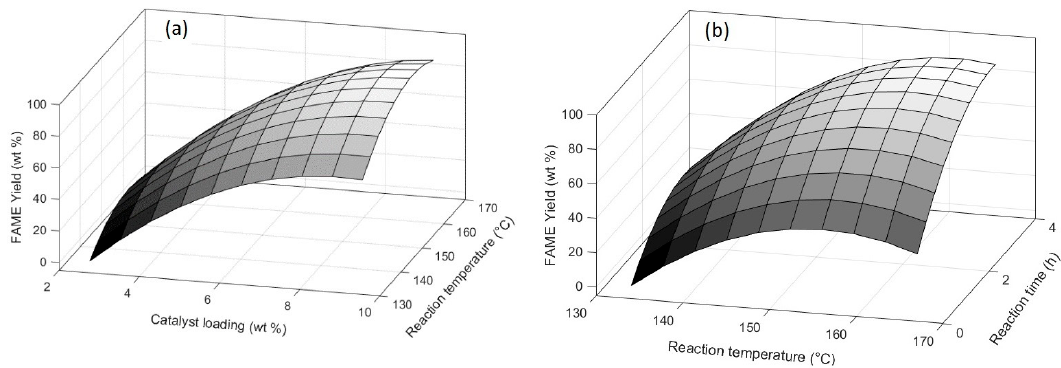
Figure 5. FAME yield response surface of the free fatty acids (FFAs) esterification as a function: ( a ) The catalyst loading and temperature reaction; and ( b ) reaction temperature and reaction